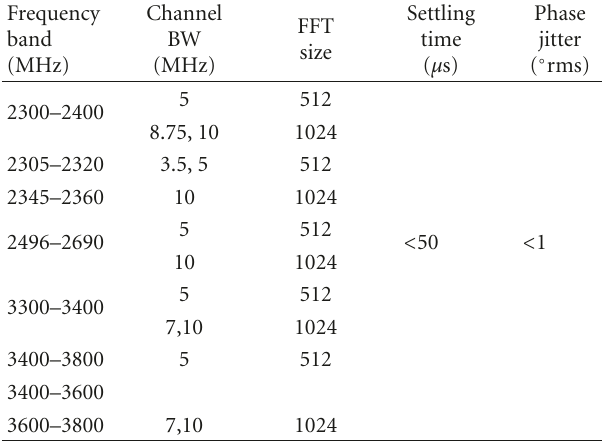
Table 1: Mobile WiMAX certification profiles [12, 14].